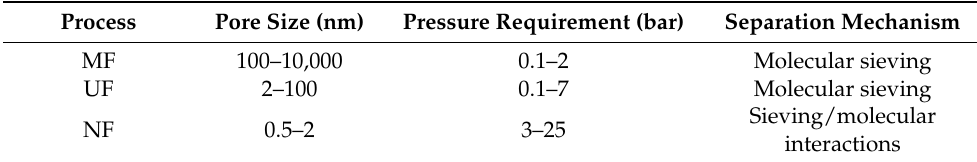
Table 1. Categorization of pressure-driven membrane technologies, their pressure requirements and separation